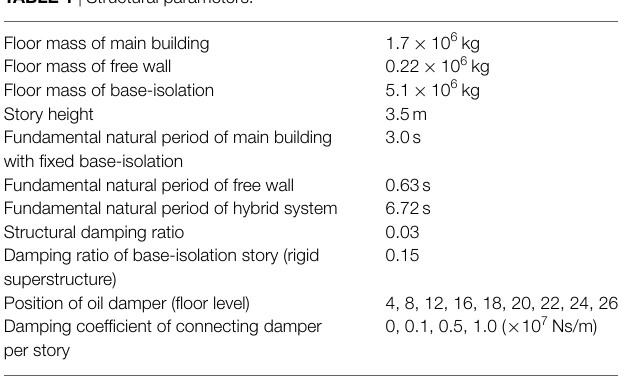
TABLE 3 | Soil conditions at Chiyoda-ku,